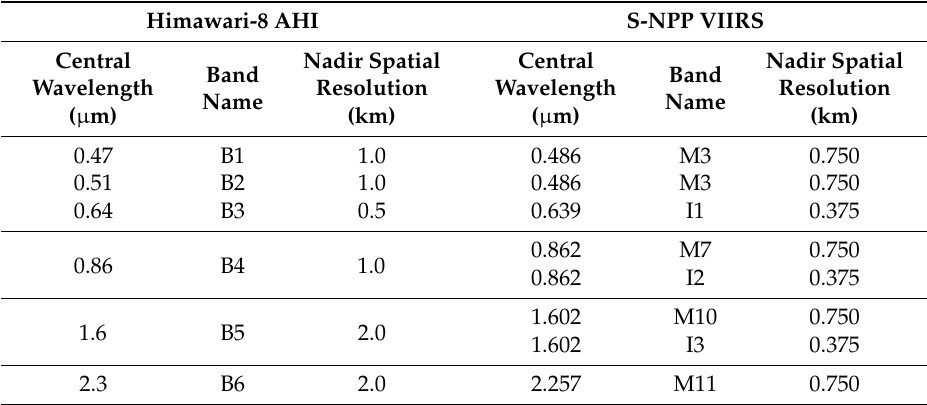
Table 1. Spectra of AHI VNIR bands and their spectrally matched VIIRS